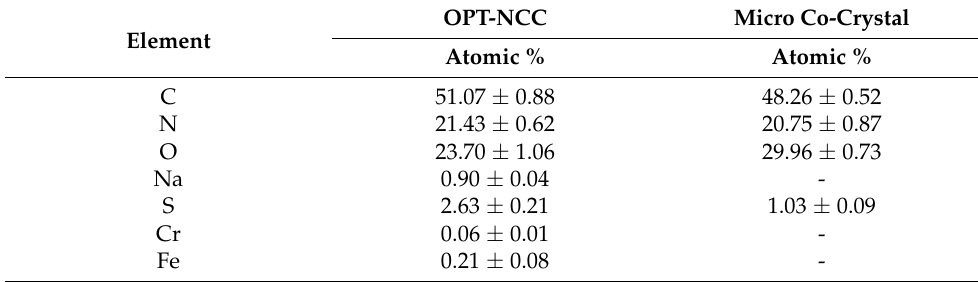
Table 8. Summary of the elemental analysis of OPT-NCC and micro